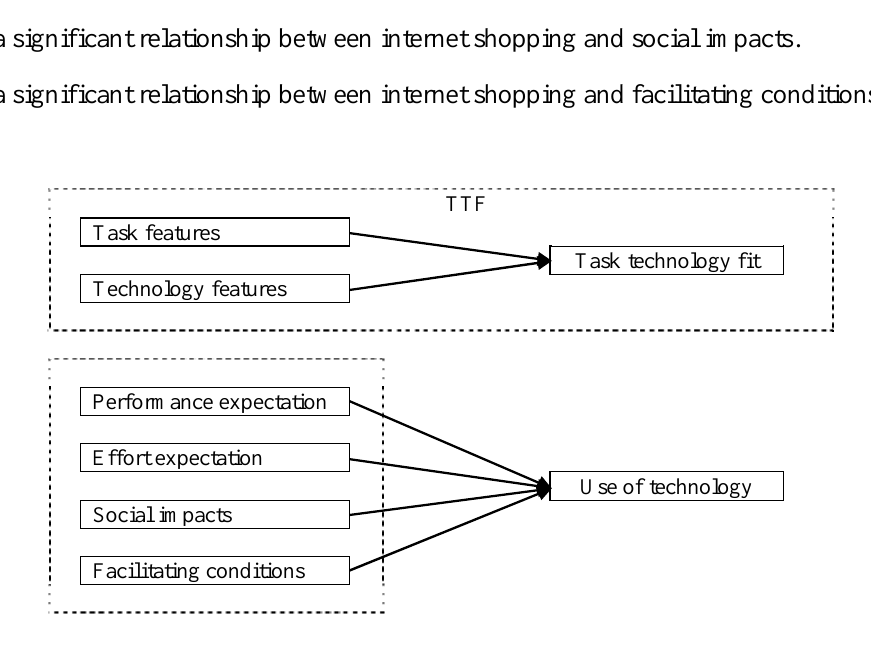
Fig. 1. The research model (Zhou et al.,